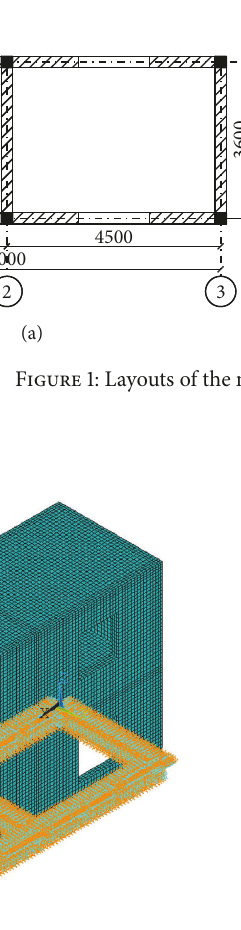
Figure 2: Full finite element model.